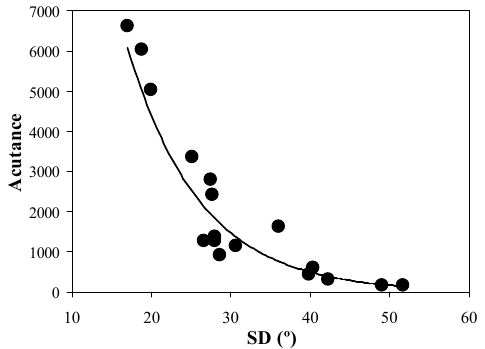
Figure 6. Acutance vs. SD values for all SHG images involved in the present experiment.